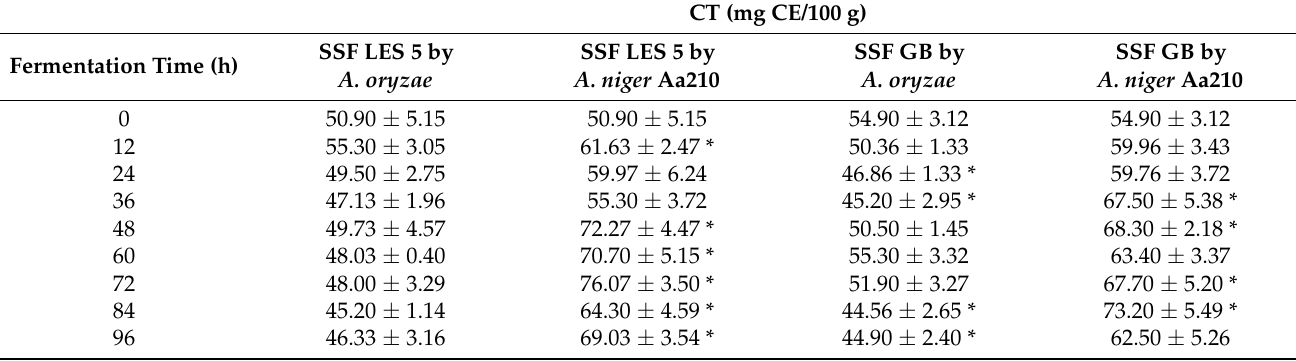
Table 3. Average condensed tannins (CT) in extracts of LES 5 and GB sorghum during solid-state fermentation (SSF) by A. oryzae and A. niger Aa210. Time 0 = unfermented extract. CT (mg CE/100